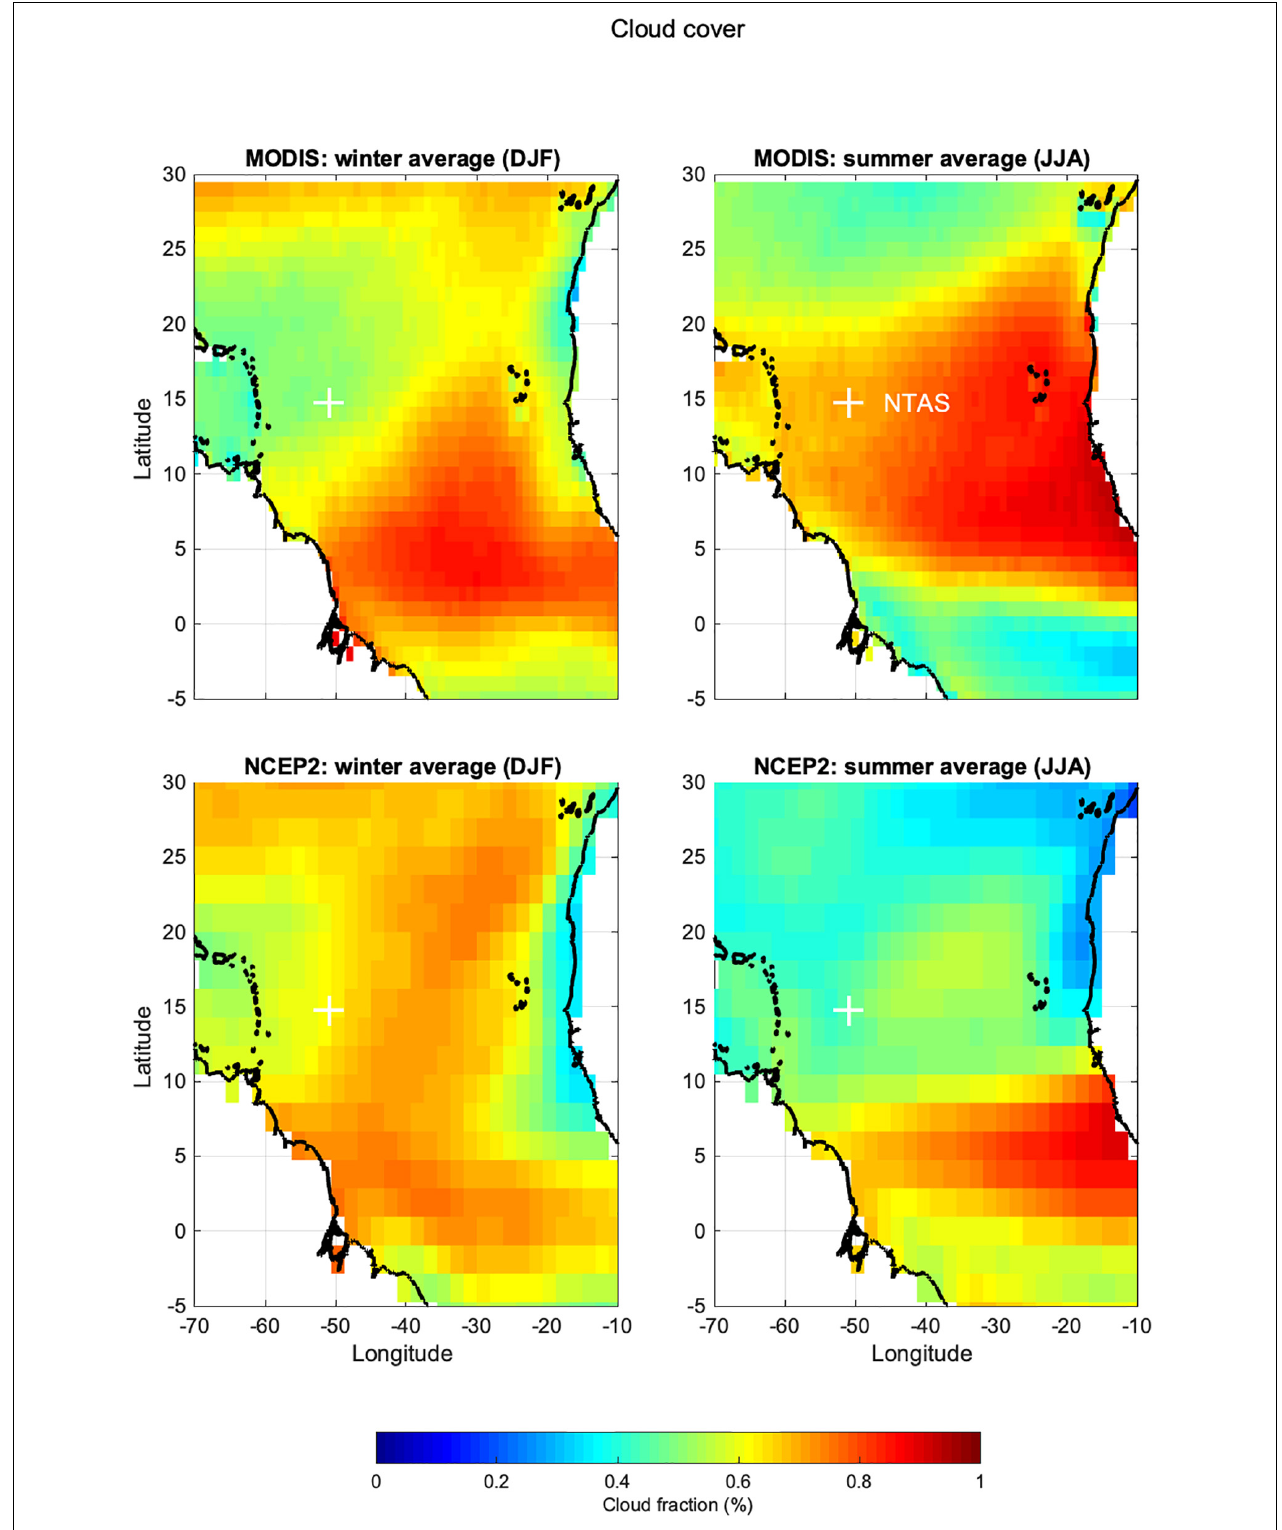
FIGURE 9 | Maps of season averaged cloud fraction from MODIS and NCEP2. Winter (DJF) and summer averages based on daily data from years 2002 through 2012. Magenta cross denotes NTAS location.